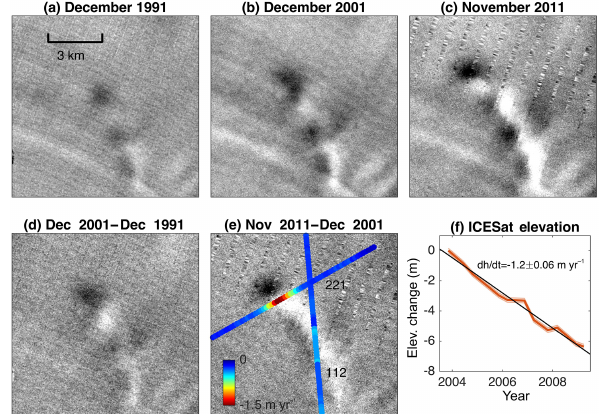
Figure 7. (a–c) Landsat images and (d–e) their difference images over the region indicated by the blue box in Fig. 6. The diagonal stripes in (c) are due to the failure of the scan line corrector of Landsat-7 ETM+ and are removed by a gap-fill method using ad- ditional images taken around the same time. The elevation change rates from the ICESat measurements are overlaid in (e) . (f) The tem- poral elevation change in the topographic sink measured along the 221 ICESat